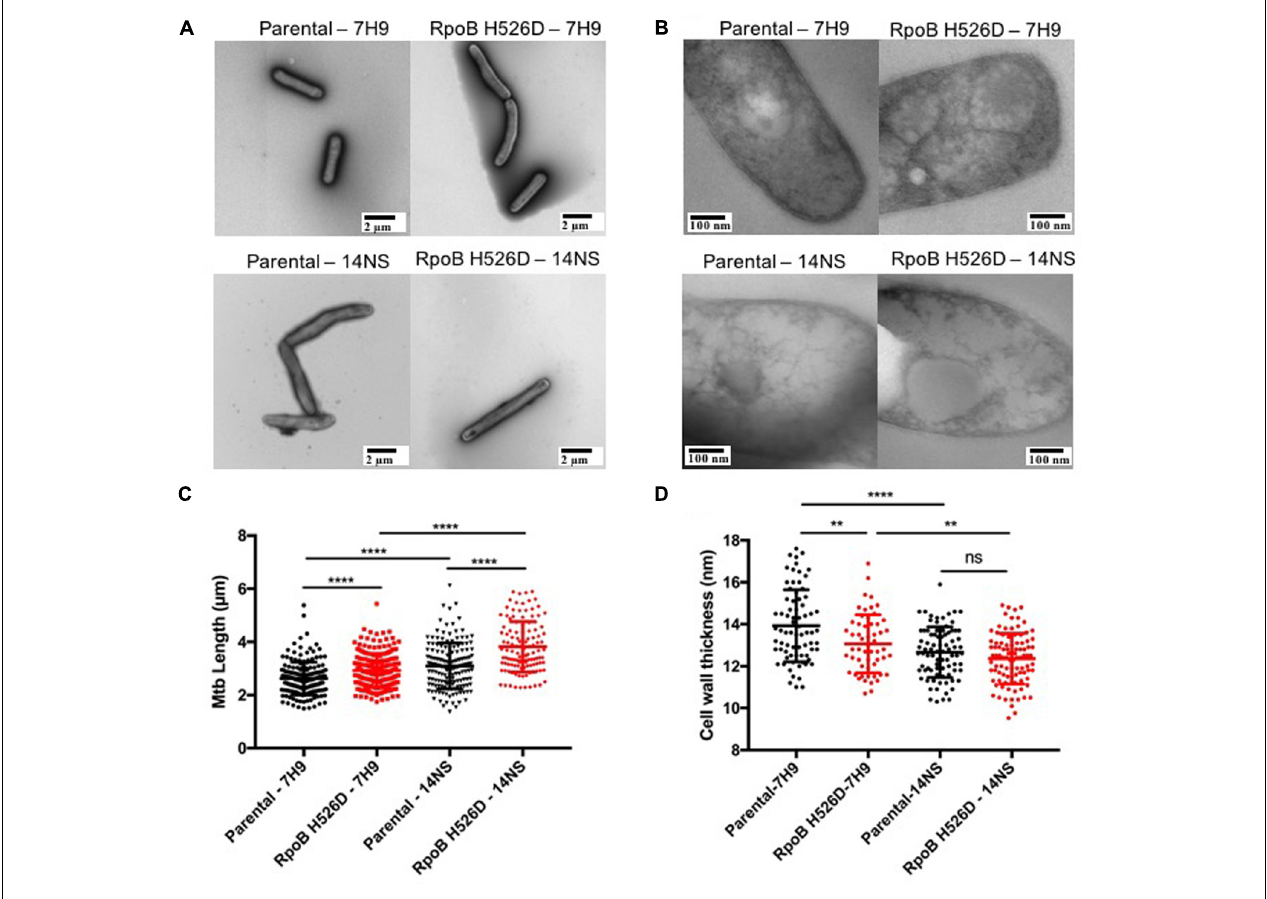
FIGURE 2 | Mycobacterium tuberculosis RpoB mutation H526D is associated with altered bacillary length and cell wall thickness. The bacillary length (A) and cell wall thickness (B) of the RpoB H526D mutant and its parental strain were evaluated by transmission electron microscopy (TEM) during mid-log-growth-phase (7H9) and after exposure to nutrient starvation for 14 days (14NS). Bars, (A) 2 µ m and (B) 100 nm. Dot plot graphs of (C) bacillary length ( µ m) and (D) cell wall thickness (nm). Each dot represents a measurement for a single bacillus. ∗∗∗∗ p < 0.0001, ∗∗ p < 0.01, ns: